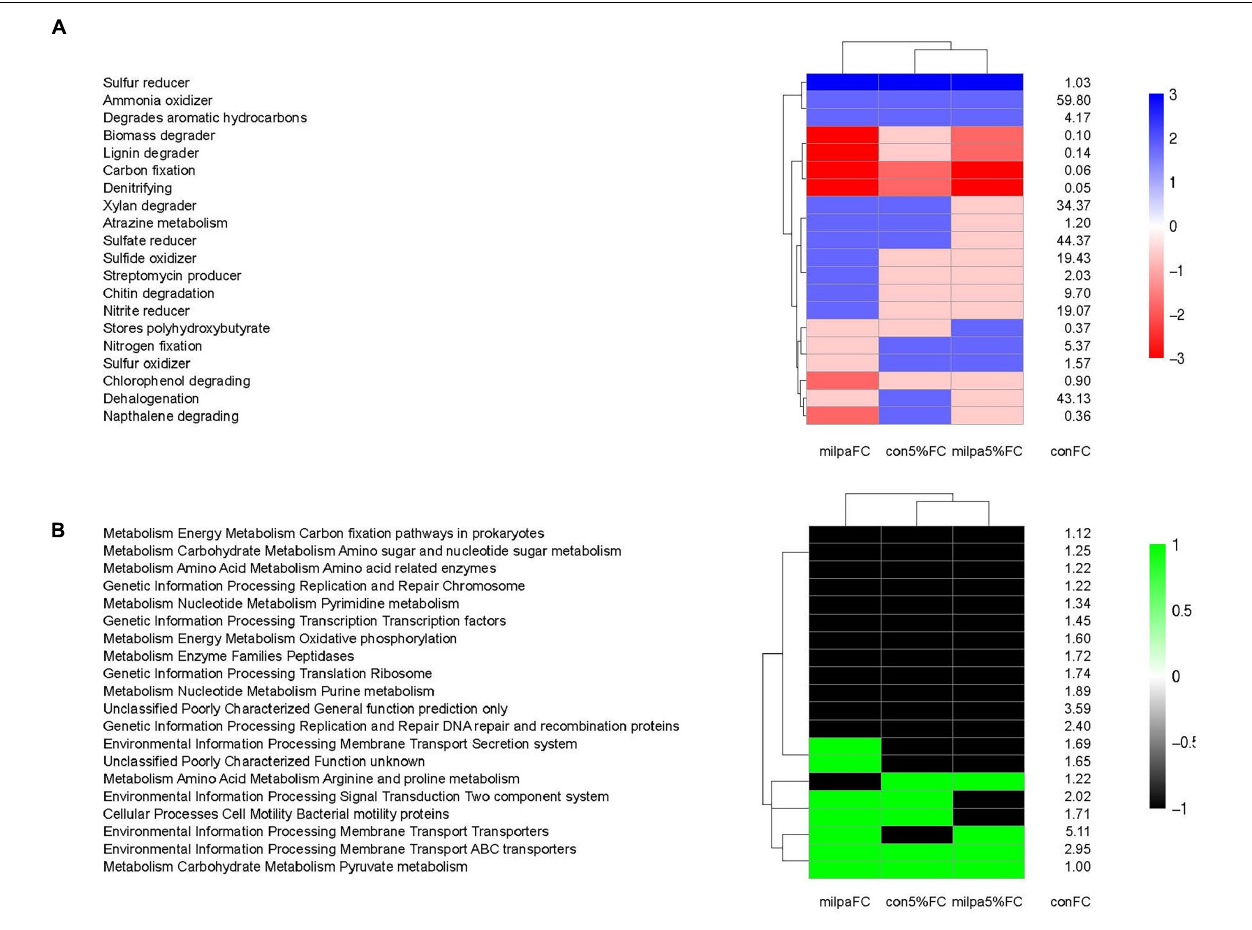
FIGURE 5 | (A) The METAGENassist metabolic functions. (B) The KEGG orthologs metabolic functions in the conventional cultivated soil incubated at field capacity (conFC) and the heat map of the ratios comparing the metabolic functions in conFC with those in the conventional cultivated soil incubated at 5% field capacity (con5%FC), the milpa soil incubated at 5% field capacity (mil5%FC), and the milpa soil incubated at field capacity (milFC). Ratio –3: the metabolic function was ≥ 5 times lower than in conFC treatment, Ratio –2: the metabolic function was < 5 times but ≥ 2 times lower than in conFC treatment, Ratio –1: the metabolic function was < 2 times but > 1 lower than in the conFC treatment, Ratio 0: the metabolic function was similar as in the conFC treatment, Ratio 1: the metabolic function was ≥ 1 times greater but < 2 greater than in the conFC treatment, Ratio 2: the metabolic function was ≥ 2 times greater but < 5 times greater than in conFC treatment, and Ratio 3: the metabolic function was ≥ 5 times greater than in conFC